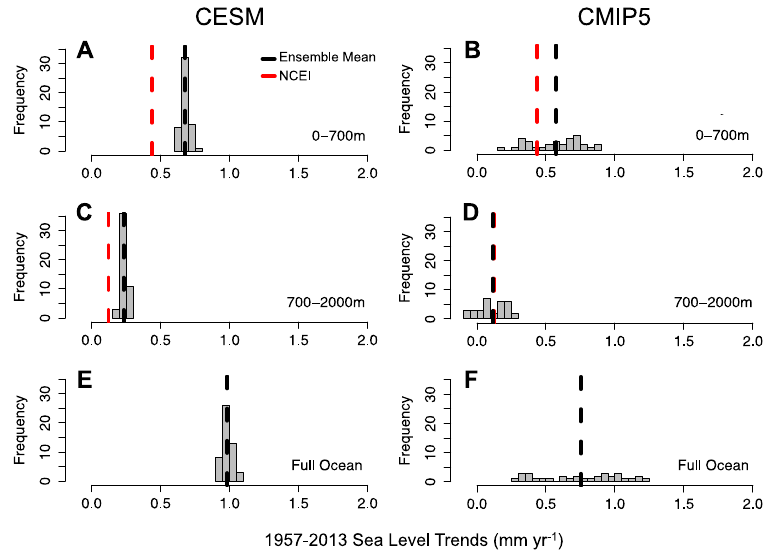
Figure 5. Histograms of model ensemble steric trends over different depth for the multi ‐ decadal period (1957–2013). Full ocean is defined as the entire available depth of each model ocean. Red dashed lines are observations from the National Center for Environmental Information (NCEI), and black dashed lines are the model ensemble means. ( A ): CESM, 0–700 m; ( B ): CMIP5, 0–700 m; ( C ): CESM, 700–2000 m; ( D ): CMIP5, 700–2000 m; ( E ): CESM, Full ocean; ( F ): CMIP5, Full ocean.